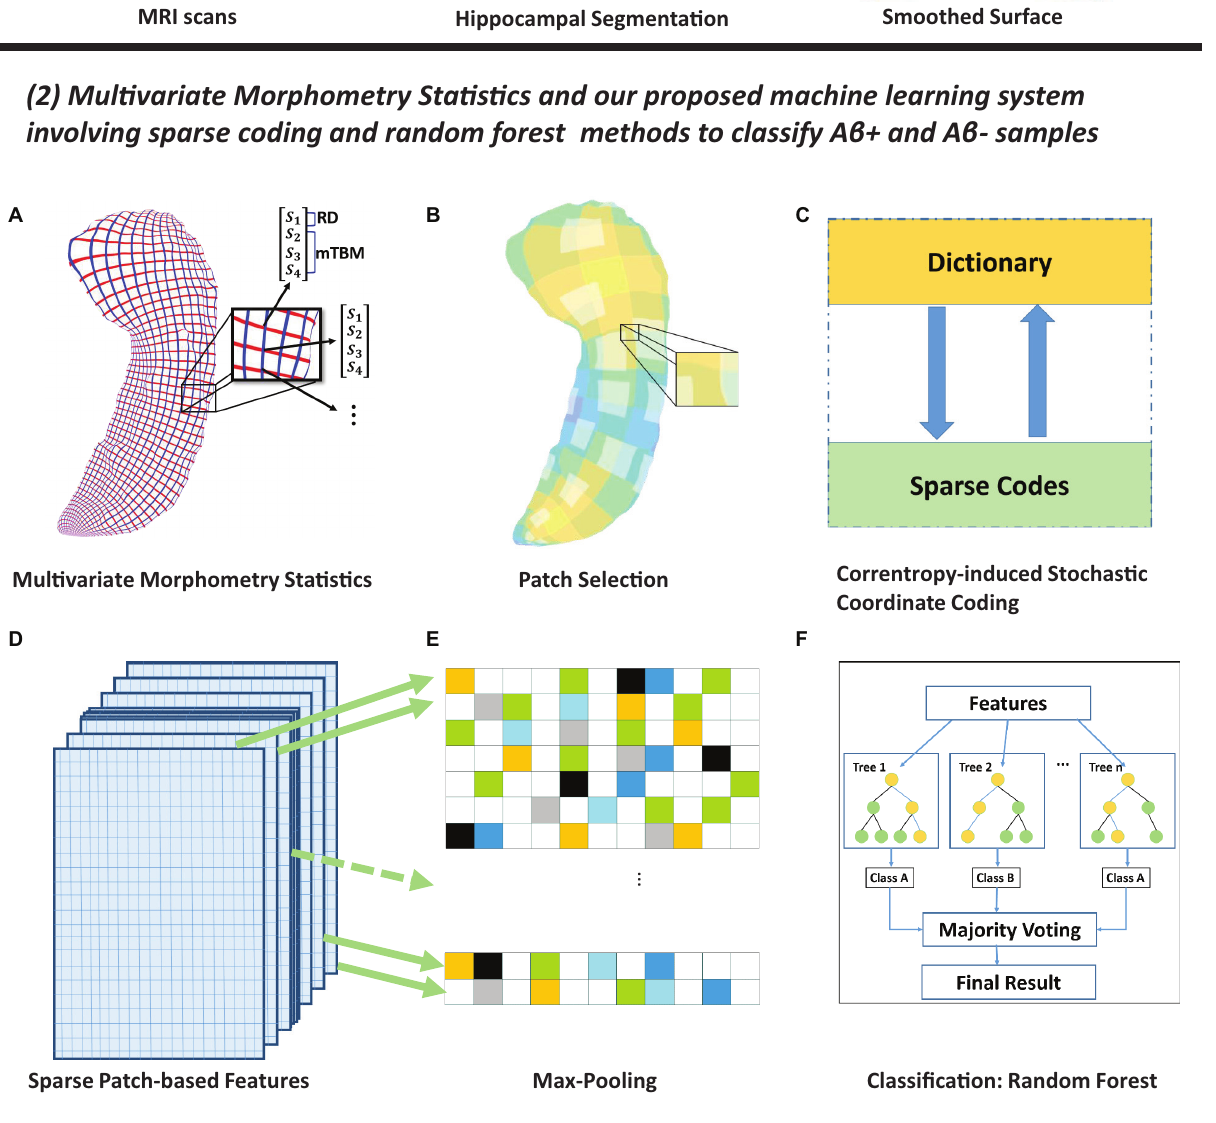
FIGURE 1 | Panel (1) shows hippocampal surfaces generated from brain MRI scans. In subfigure (A) of panel (2) , surface-based multivariate morphometry statistics (MMS) are calculated after fluid registration of surface coordinates across subjects. MMS is a 4 × 1 vector on each vertex, including radial distance (scalar) and multivariate tensor-based morphometry (3 × 1 vector). In subfigures (B,C) , we randomly select patches on each hippocampal surface and generate a sparse code for each patch with our novel Patch Analysis-based Surface Correntropy-induced Sparse-coding (PASCS) method. In subfigures (D,E) , we apply the max pooling operation to the learned sparse codes to generate a new representation (a vector) for each subject. In subfigure (F) , we train binary random forest classifiers on these representations and validate them with 10-fold cross-validation.